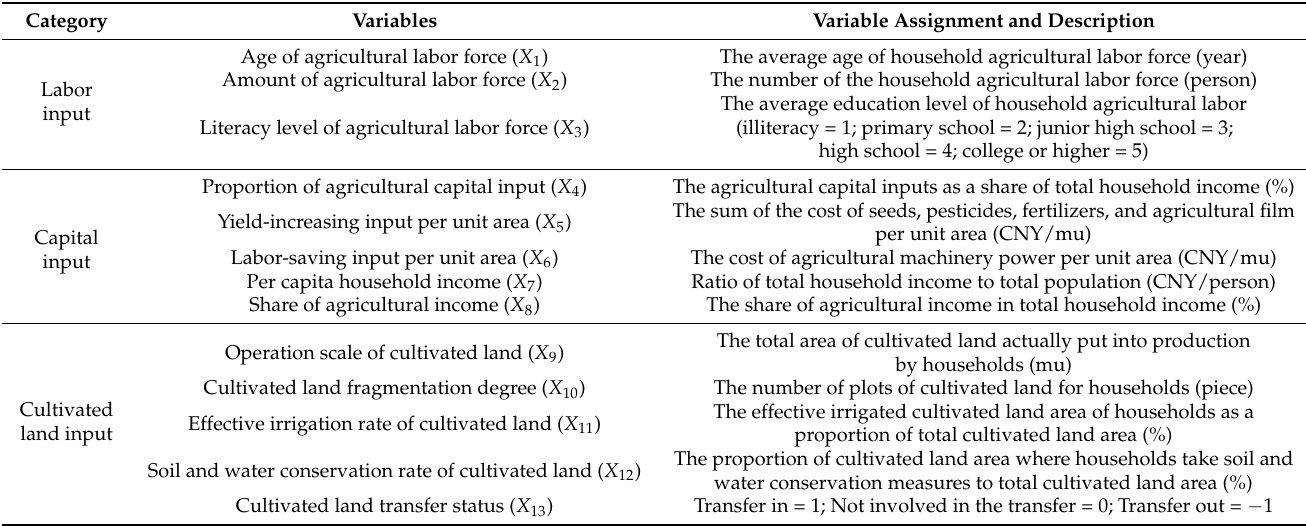
Table 3. Evaluation indicators of factors influencing the